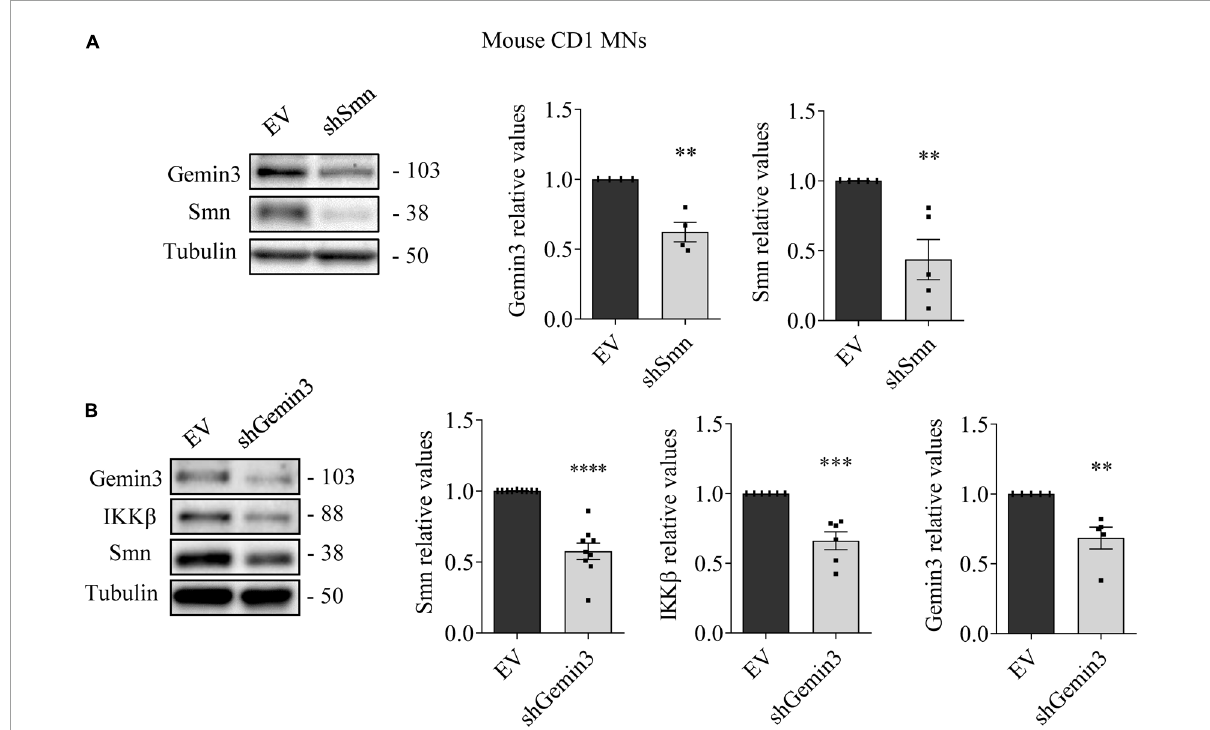
FIGURE4 Survival motor neuron (SMN) and Gemin3 protein level inter-regulation in mouse motoneurons (MNs). Cultured mouse CD1 MNs were transduced with shSmn (A) , shGemin3 (B) , or empty vector (EV) (A,B) lentiviral constructs. Seven days after transfection, protein extracts were obtained and submitted to western blot using anti-Gemin3, anti-IKK β , and anti-SMN antibodies. Membranes were reprobed using anti- α -tubulin antibody. Graph values represent the expression of Gemin3 (A,B) , IKK β (B) or SMN (A,B) versus α -tubulin and correspond to the quantification of at least four independent experiments ± SEM. Asterisks indicate significant differences using Student t -test ( ∗∗ p < 0.01, ∗∗∗ p < 0.001; ∗∗∗∗ p <